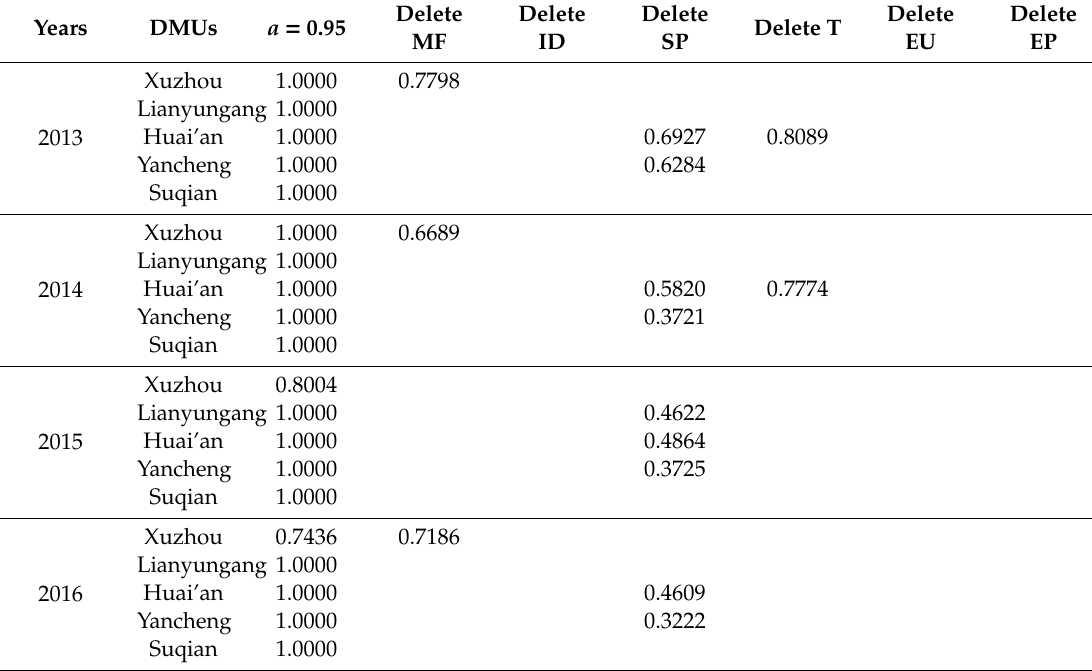
Table A10. The changes of stochastic e ffi ciency value by deleting grouping input variables in Northern Su ( α = 0.95).